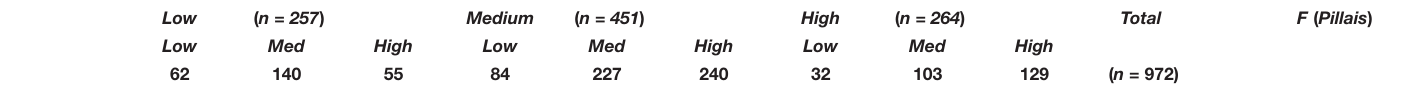
TABLE 3 | Combined effects (3 × 3) between levels of Self-Regulation (SR) and levels of Regulatory Teaching ( RT ) on Learning Approches ( n = 972).